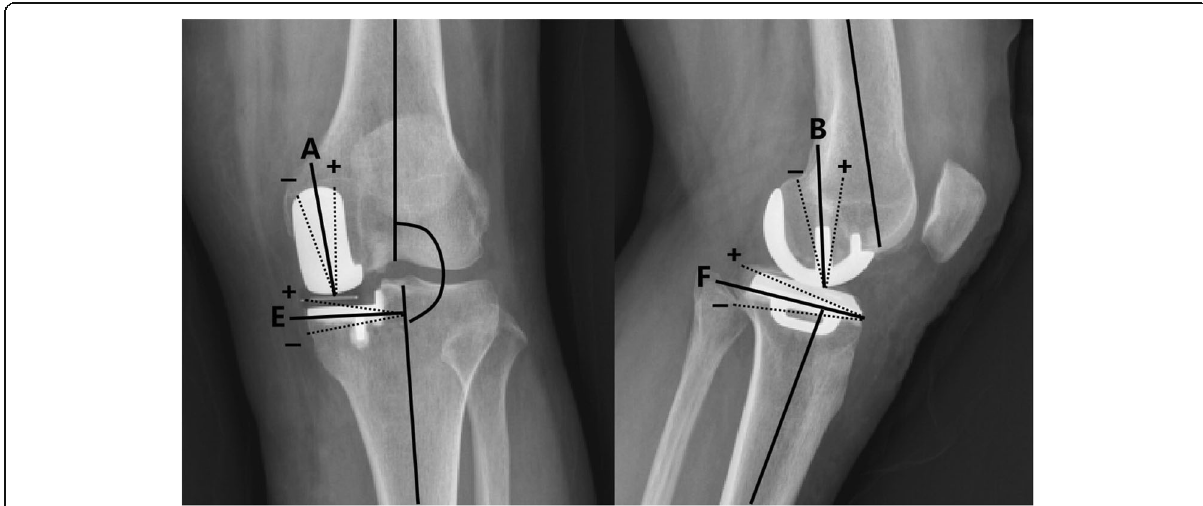
Fig. 1 Measurement of FTA and component alignments. FTA, femorotibial angle. Angle A defined as femoral component varus/valgus angle; angle B was flexion/extension angle of femoral component; angle E defined as tibial component varus/valgus angle; angle F was posterior tibial component